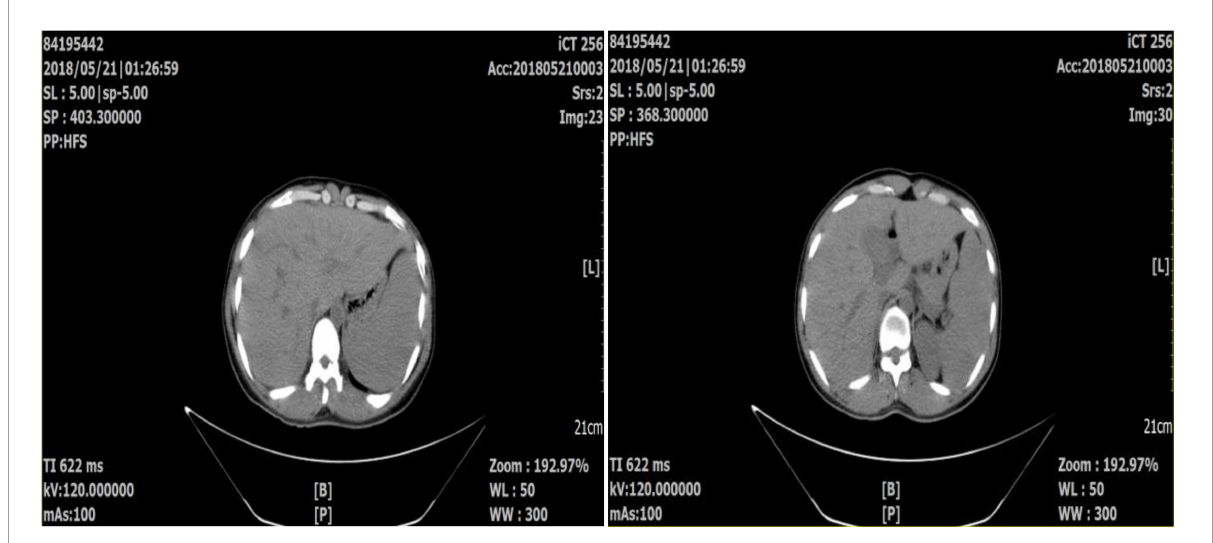
FIGURE1 Abdominal computed tomography showed no splenic